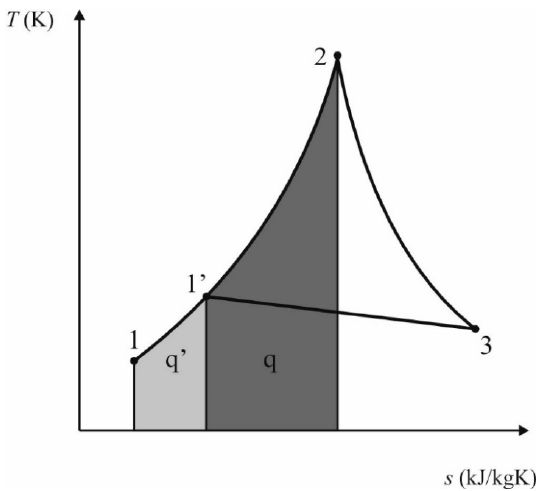
Figure 14. Isobaric heating, isenthalpic throttling and polytropic expansion of natural gas depicted in the T-s diagram.